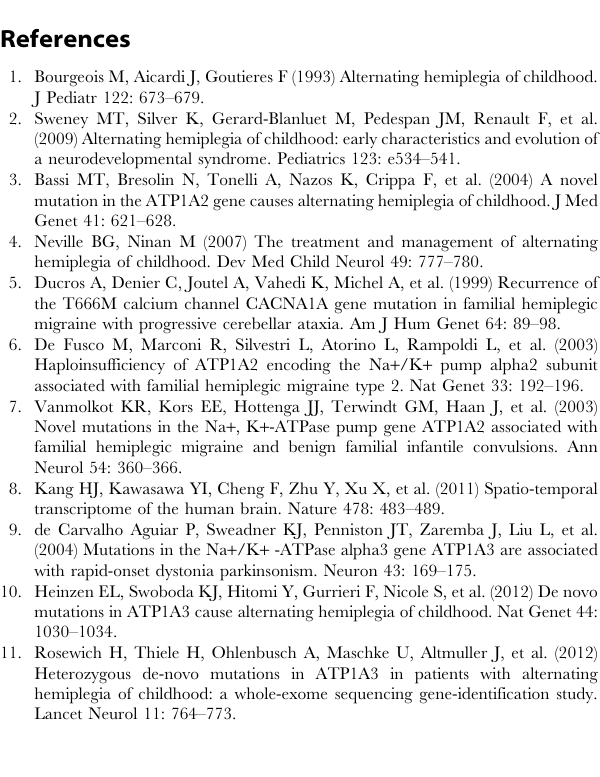
Figure S1 Rations of single nucleotide variations (SNVs) overlapping with known polymorphisms in various ethnic backgrounds.